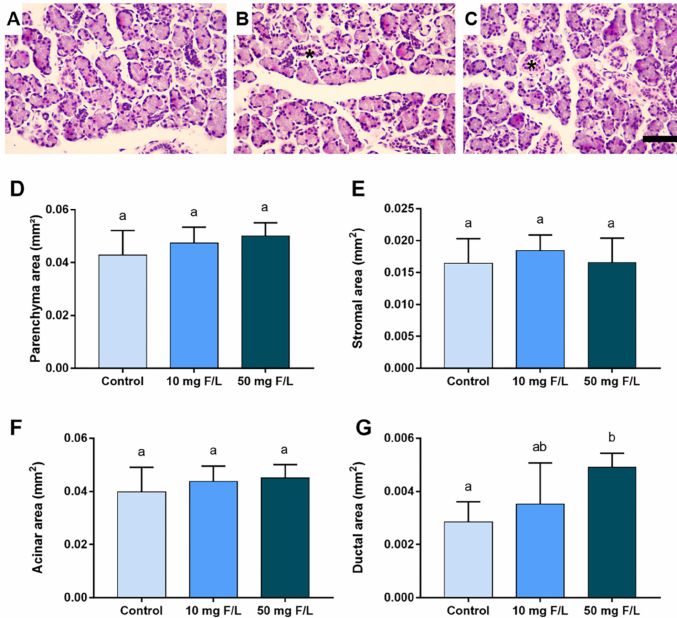
Figure 3. Morphometric analysis of the tissues that comprise the submandibular glands of the offspring indirectly exposed to water containing 0 (control), 10, or 50 mg F/L for 42 days ( n = 5 animals/group). ( A – C ) represent the submandibular glands of the control, 10 and 50 mg F/L groups, respectively; in ( D ), parenchyma area (mm 2 ); in ( E ), stromal area (mm 2 ); in ( F ), area of acini (mm 2 ); in ( G ), duct area (mm 2 ). Quantitative results are expressed as mean ± standard error, one-way ANOVA with Tukey’s post-test. Different letters indicate statistical difference ( p < 0.05). The asterisk indicates the location of the ducts. Scale bars: 10 µ m.